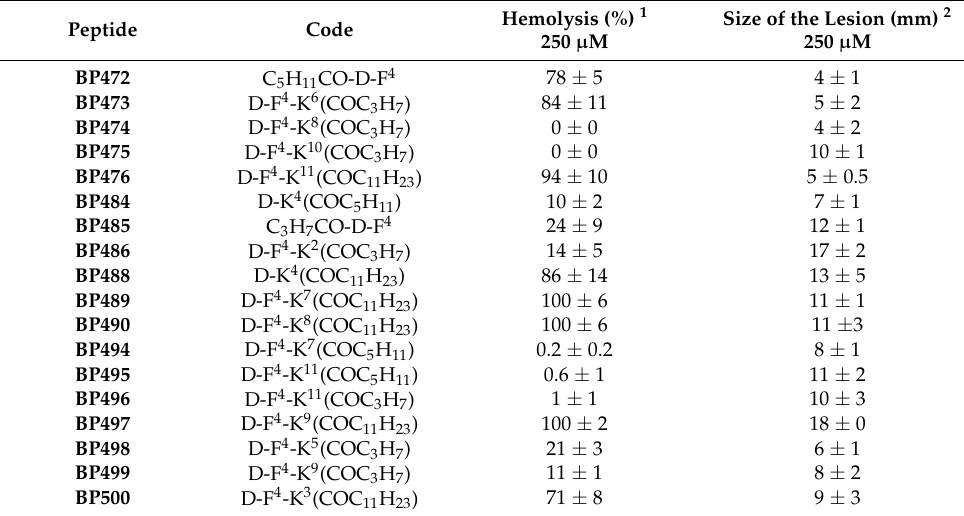
Table 2. Hemolytic activity and size of the lesion in infiltrated tobacco leaves of lipopeptides.